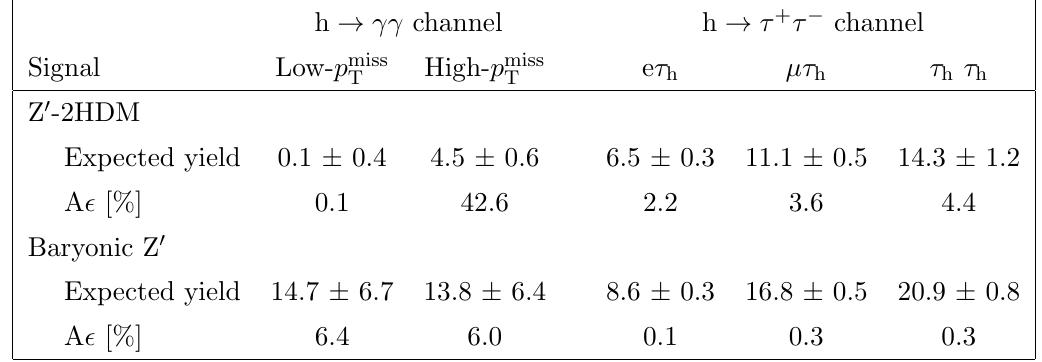
A discussion of the results for the Z 0 -2HDM interpretation is presented in section